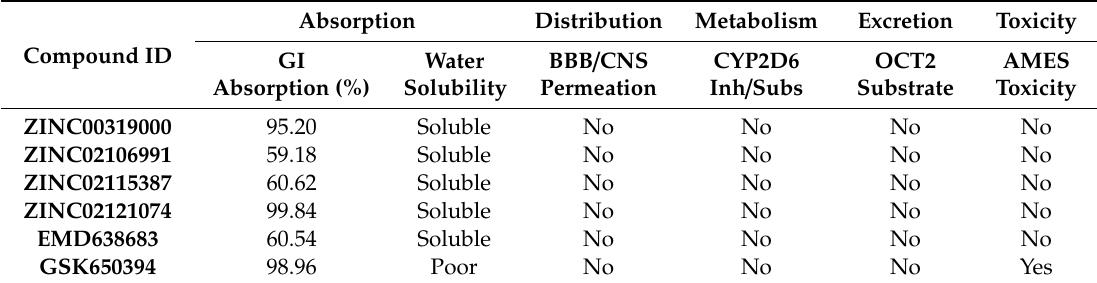
Table 2. Absorption, Distribution, Metabolism, Elimination, and Toxicity (ADMET) properties of the selected compounds.